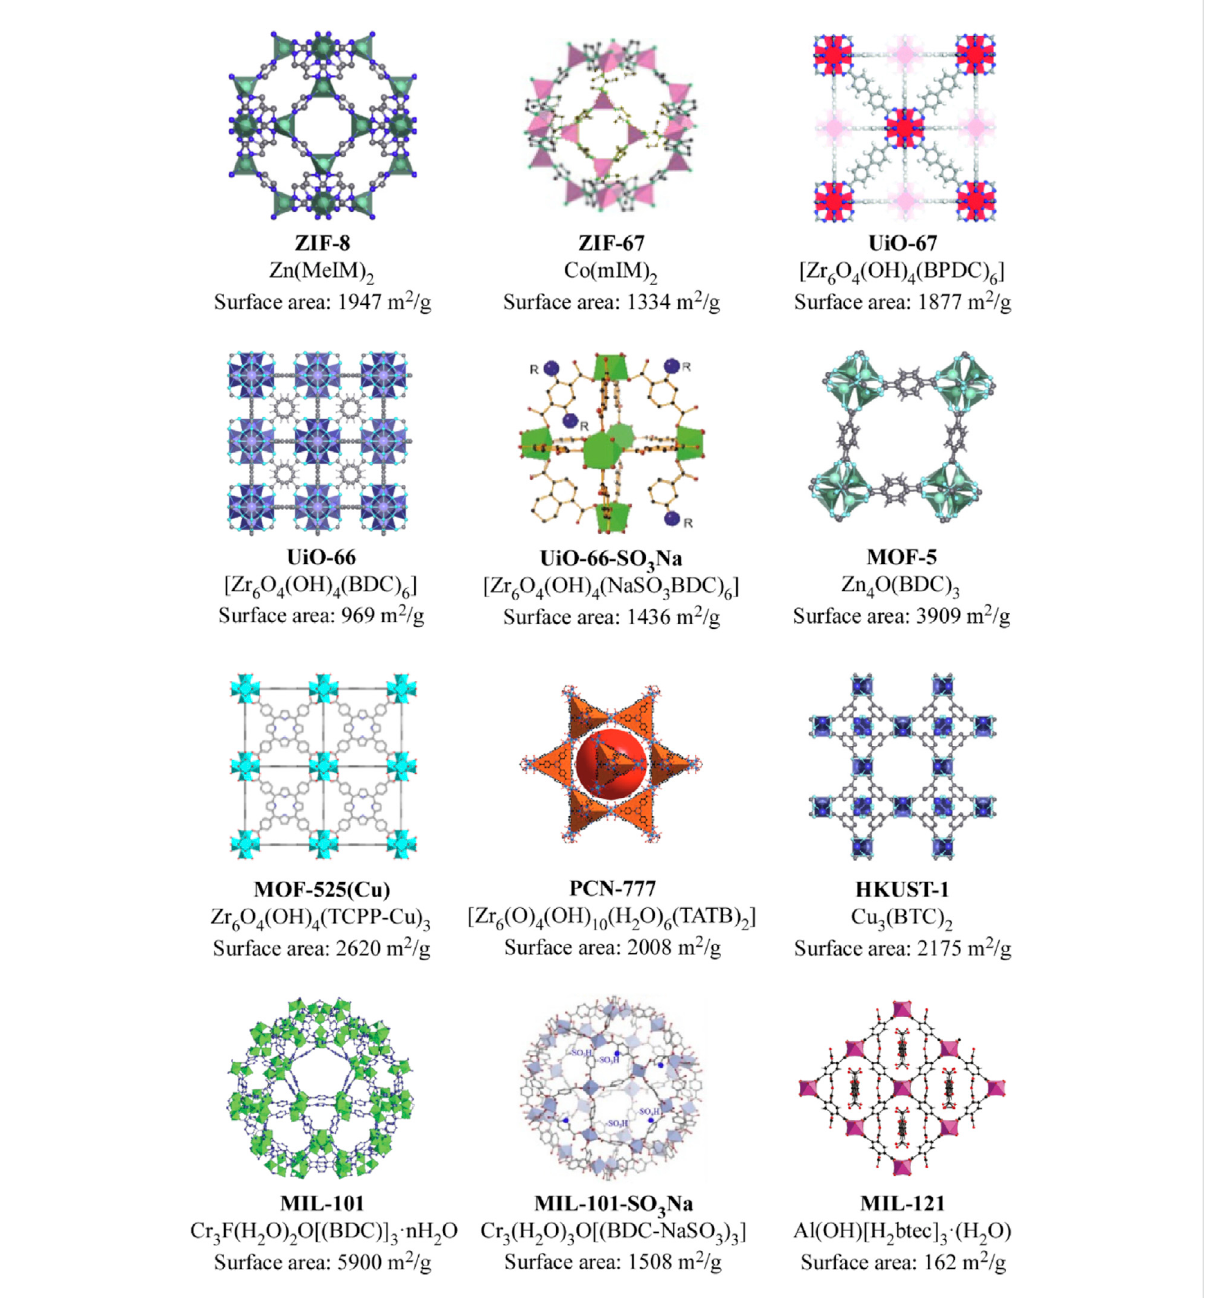
FIGURE 4 Summary of the characteristics of MOFs used for IL incorporation as electrolytes in sodium and lithium based batteries. (Férey et al., 2005; Banerjee et al., 2008; Volkringer et al., 2010; Chavan et al., 2012; Feng et al., 2015; Shaikh et al., 2019; Oozeerally et al., 2021; Yang and Kou,